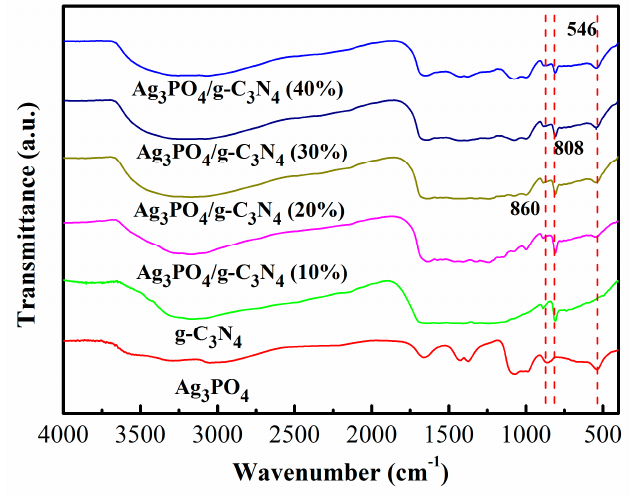
Figure 2. FTIR spectra of the as ‐ prepared g ‐ C 3 N 4 , Ag 3 PO 4 , and Ag 3 PO 4 /g ‐ C 3 N 4 (X) composites.